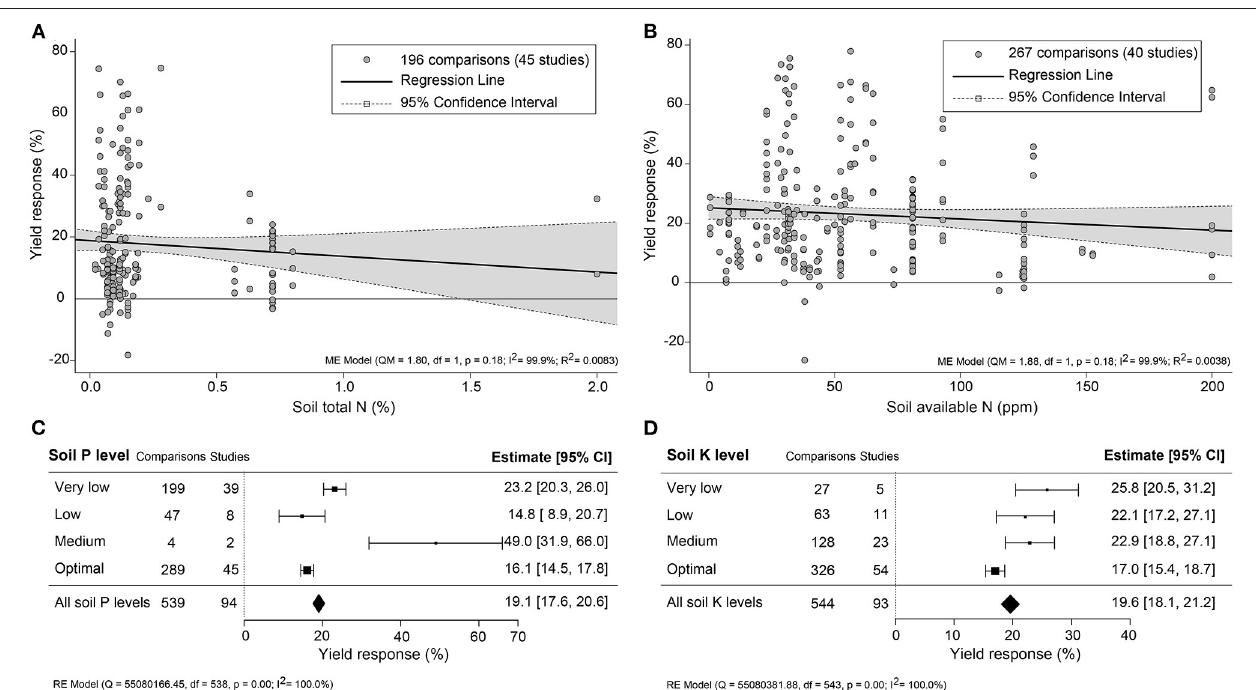
FIGURE 7 | Percentage yield response to biostimulant application as affected by the macronutrient levels, including (A) soil total N (%), (B) soil available N (ppm), soil (C) P, and (D) K levels. The point size correlates to the estimate’s precision, and the error bars represent 95% confidence intervals (CI) of mean estimated effect sizes. The number of comparisons and studies is indicated in each line or each legend. The combined effect estimates and the heterogeneity test on the models [mixed-effect models (ME) in (A,B) , and random-effect models (RE) in (C,D) ] were summarized at the bottom, where the heterogeneity test is significant ( p < 0.001) and I 2 ≥ 75% implies substantial